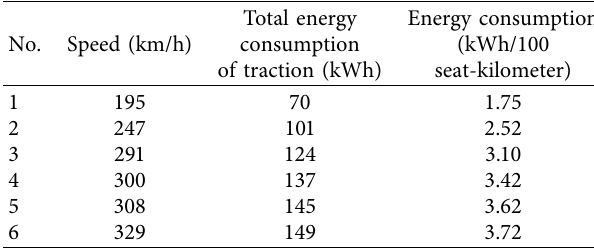
Table 6: Traction energy consumption of CRH2 EMU in the downhill line at different constant speed levels.